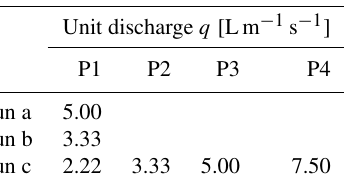
Table 1. Summary of unit discharges q ( Q/W ) used in each phase (P) of experimental runs